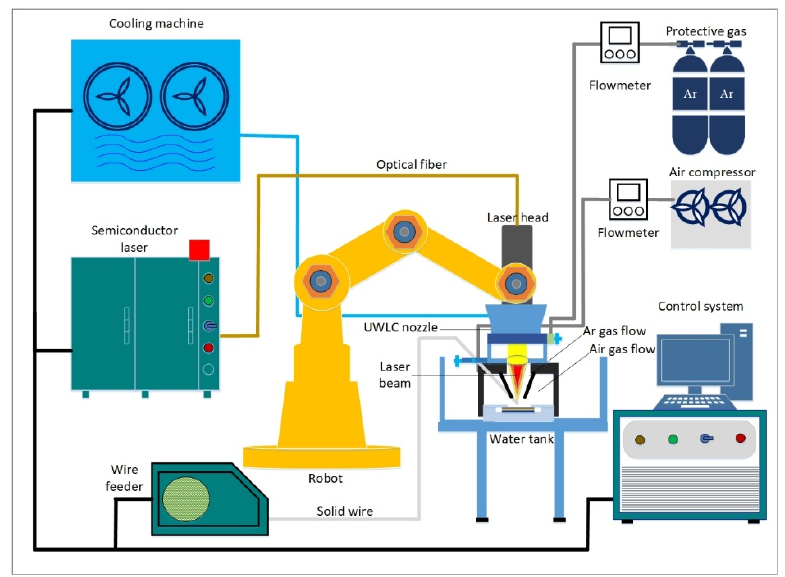
Figure 1. Schematic diagram of the UWLC experiment system.